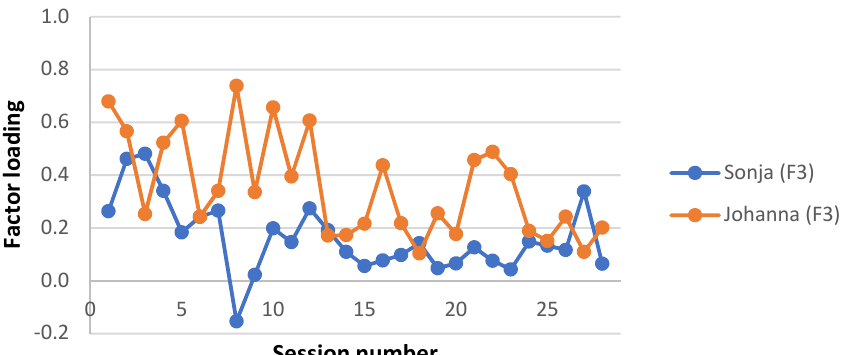
Figure 3. Interaction structure: “Fragile self-image”. Factor loadings on each session for Sonja